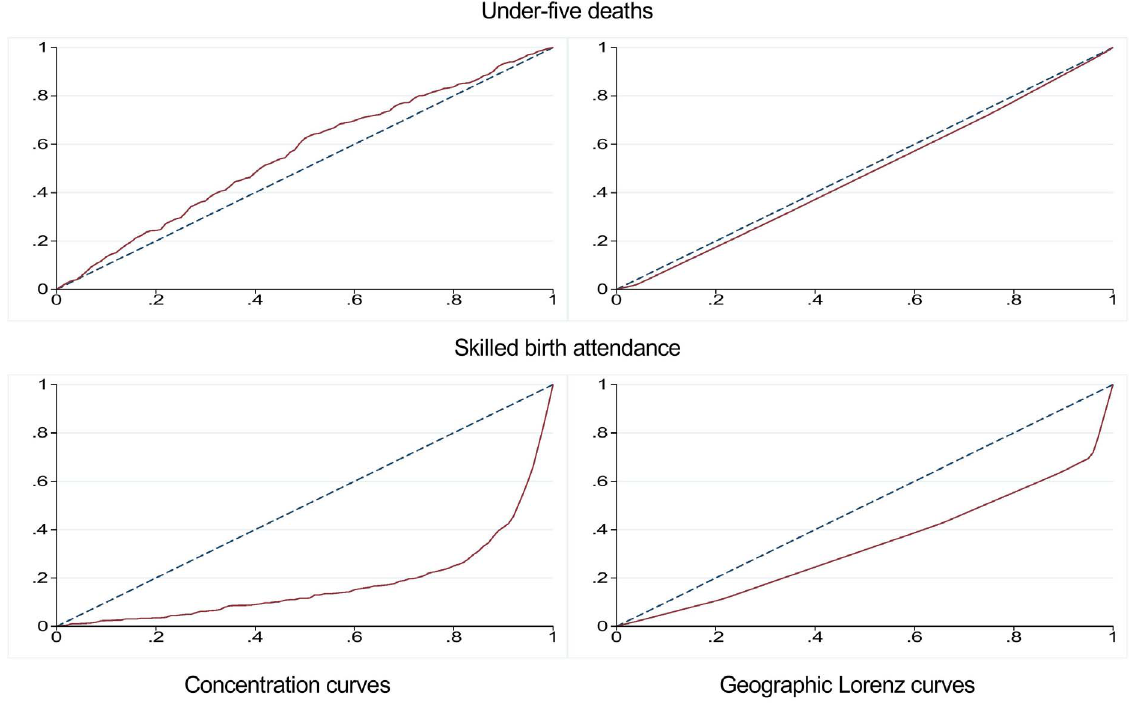
Figure 1. Concentration curves and geographic Lorenz curves for under-five deaths and skilled birth attendance in 2011. The two figures to the left are concentration curves, with the cumulative proportion of the individuals ranked by wealth on the x-axis and the cumulative proportion of the outcome variable on the y-axis. The two figures to the right are geographic Lorenz curves, with the cumulative proportion of the regions ranked from worst to best achievement of the indicator, and weighed by population size on the x-axis. The cumulative proportion of the outcome variable is on the y-axis. The solid red lines represent the concentration and Lorenz curves, and the dashed blue lines represent the ‘‘line of equality’’.